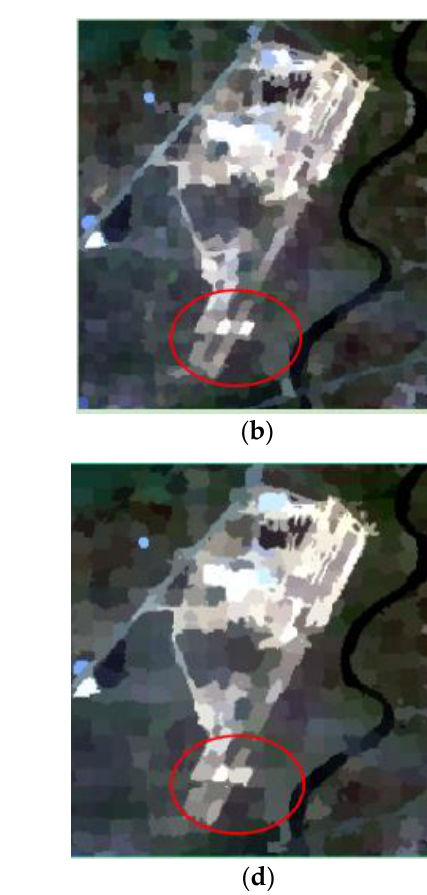
Figure 9. Results of different segmentation steps for GF-1 satellite imagery: ( a ) S = 5; ( b ) S = 7; ( c ) S = 9; ( d ) S = 11.